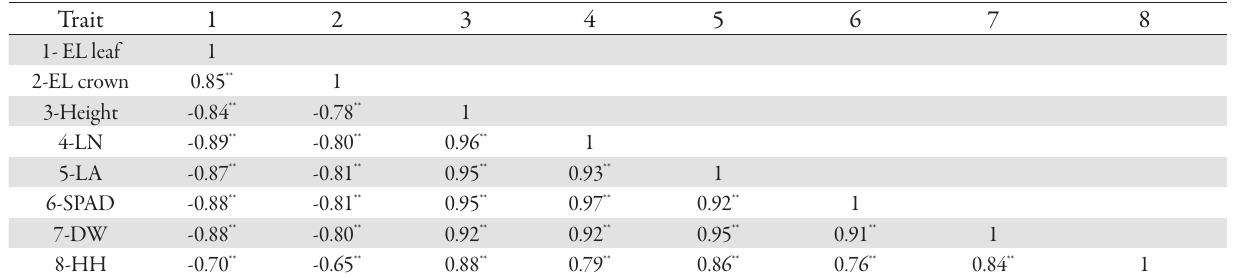
Tab. 6. Correlation coefficients between plant parameters exposed to different freezing temperature and recovery in greenhouse